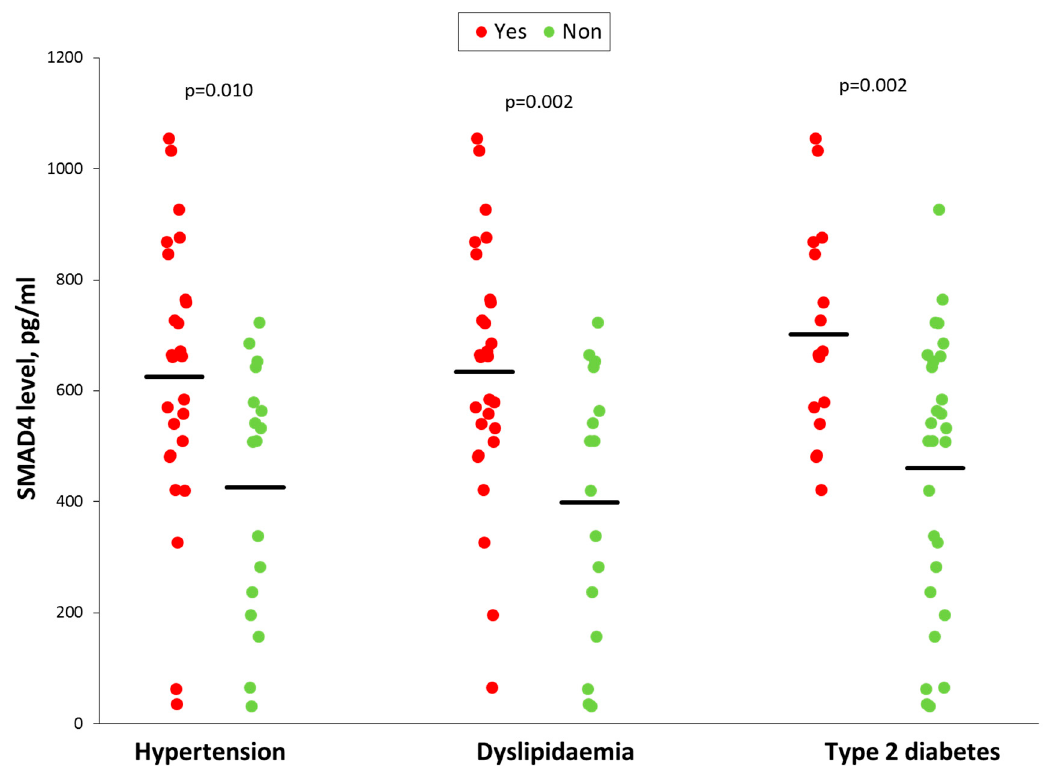
Figure 6. Comparison of plasma levels of Smad4 in OSA patients based on the presence or absence of hypertension, dyslipidaemia, or type 2 diabetes. Individual values are shown. Horizontal lines represent mean values. Comparisons were performed by t-Student test.